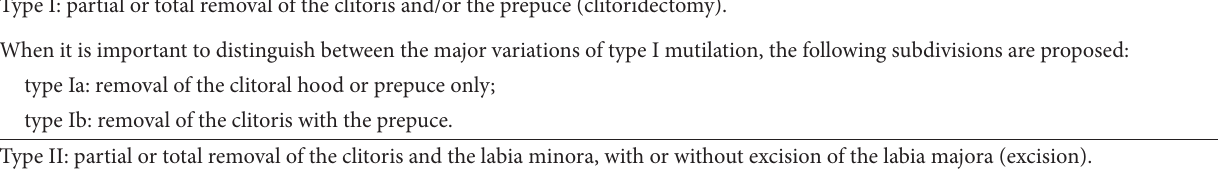
Table 1: WHO typology,